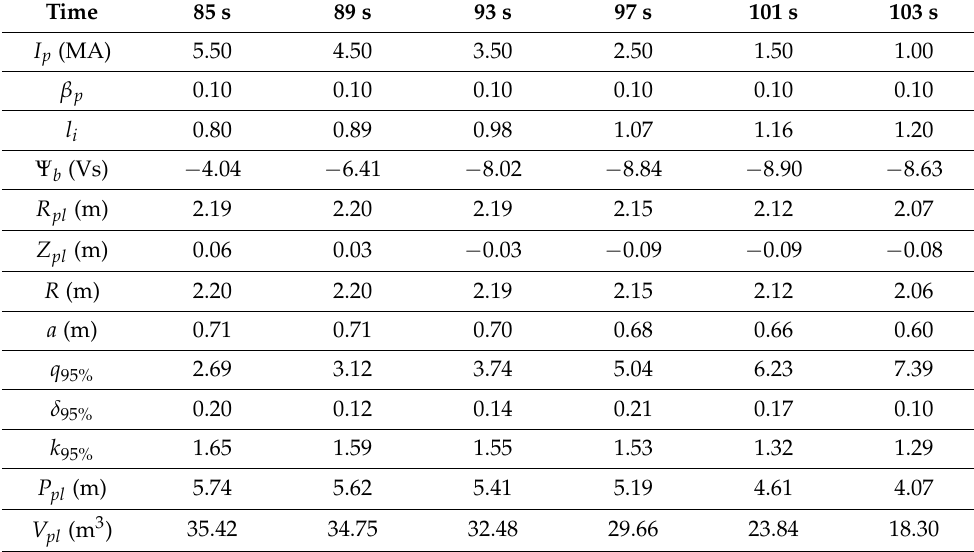
Table 8. Time evolution of main plasma parameters of the SN ramp-down phase at 250 kA/s.